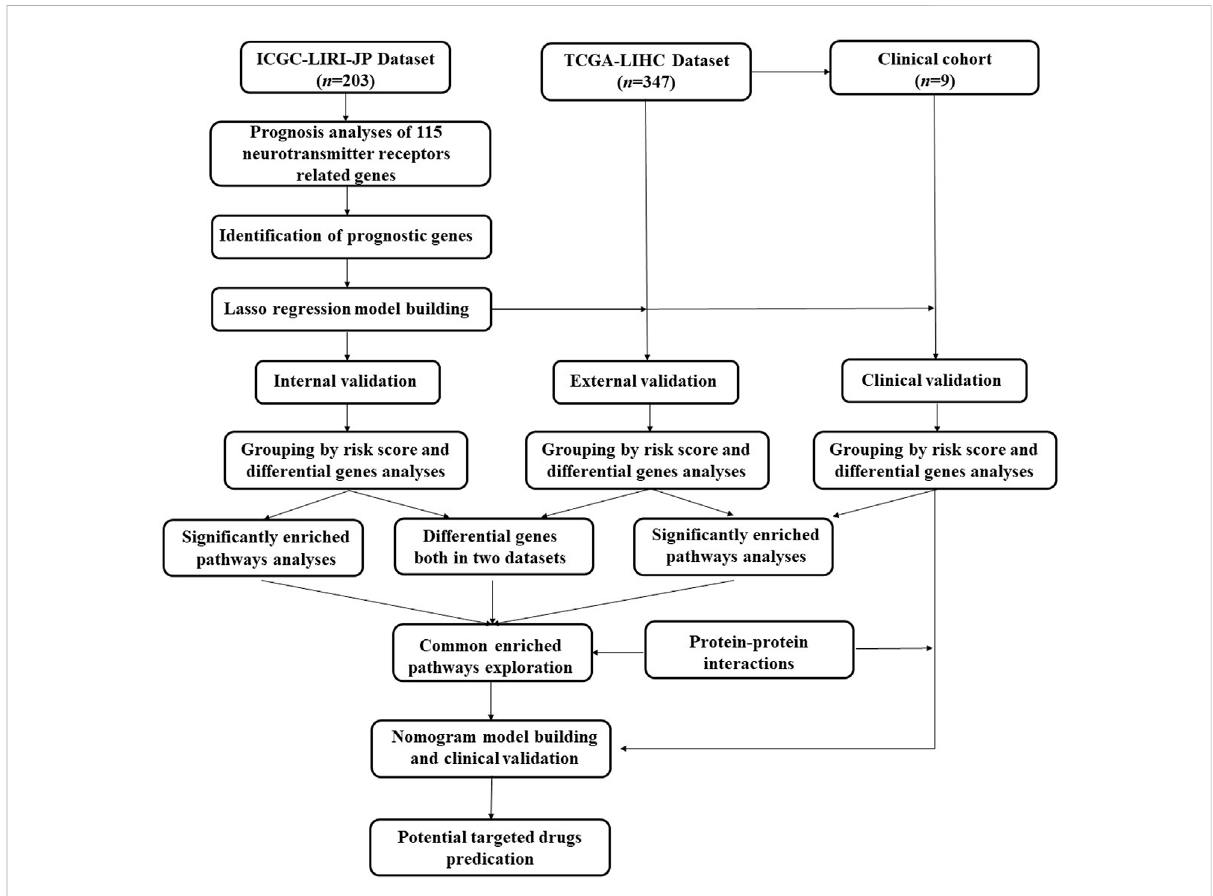
FIGURE 1 Design fl ow chart and validation process of prognosis model